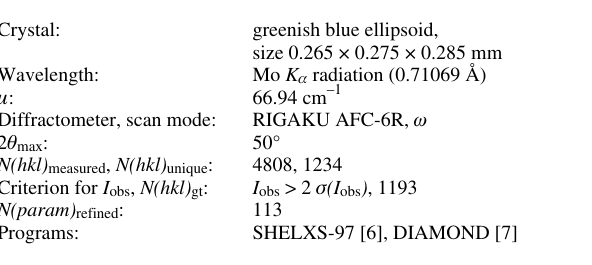
Table 13. Data collection and handling. Table 14. Atomic coordinates and displacement parameters (in Å 2 ) .